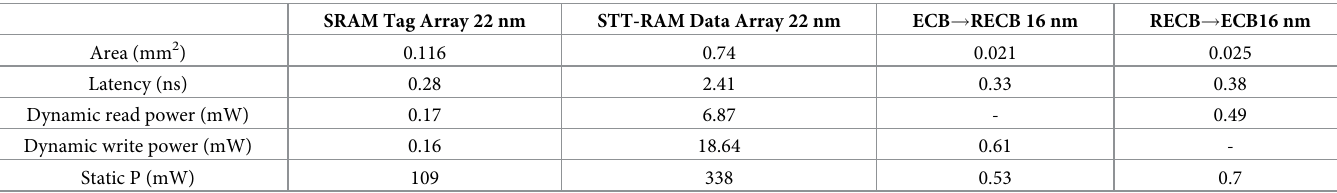
Table 2. Hardware cost